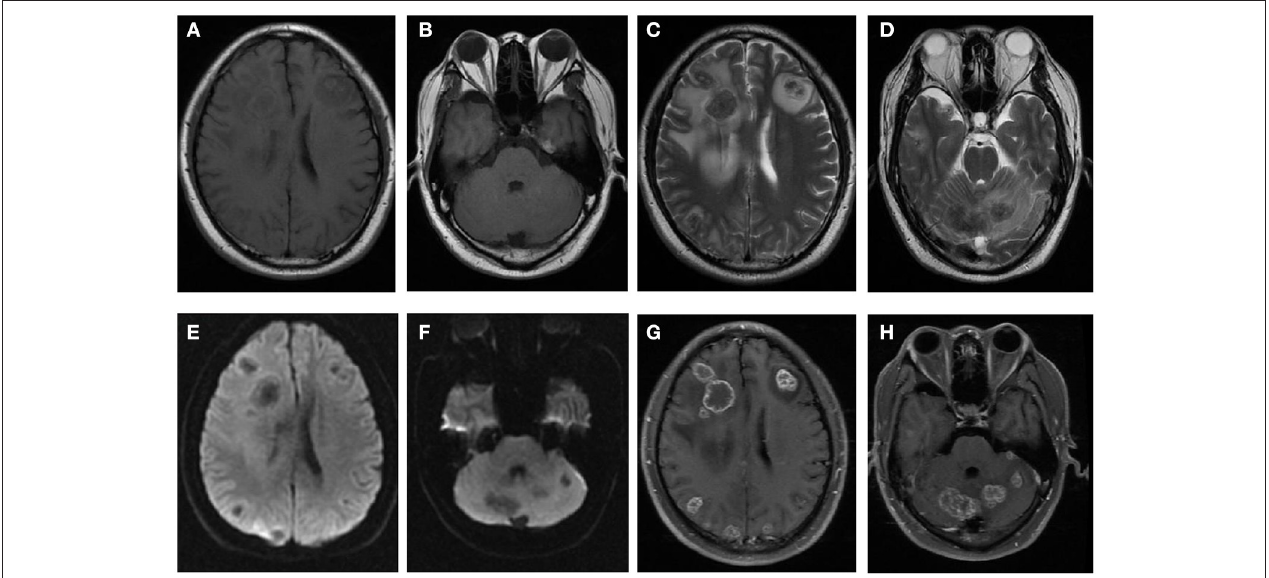
FIGURE 1 | Brain MRI images of the patient. Multiple lesions revealed with isointensity on T1WI (A,B) , hypointensity on T2WI (C,D) surrounded by edema, hypointensity on DWI (E,F) and irregular ring enhancement after injection of Gd-DTPA (G,H)